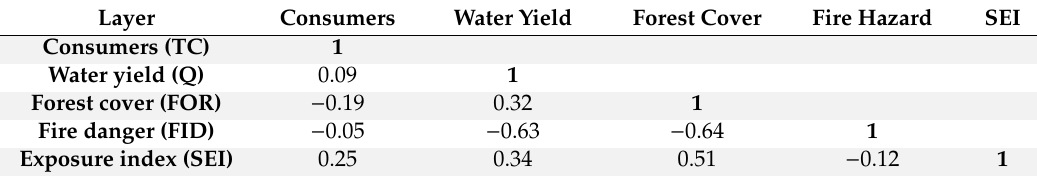
Table 2. Correlation coe ffi cients between input variables and the exposure index. Values relative to the total amount of downstream consumers (TC), a raster grid of population distribution, were added to the